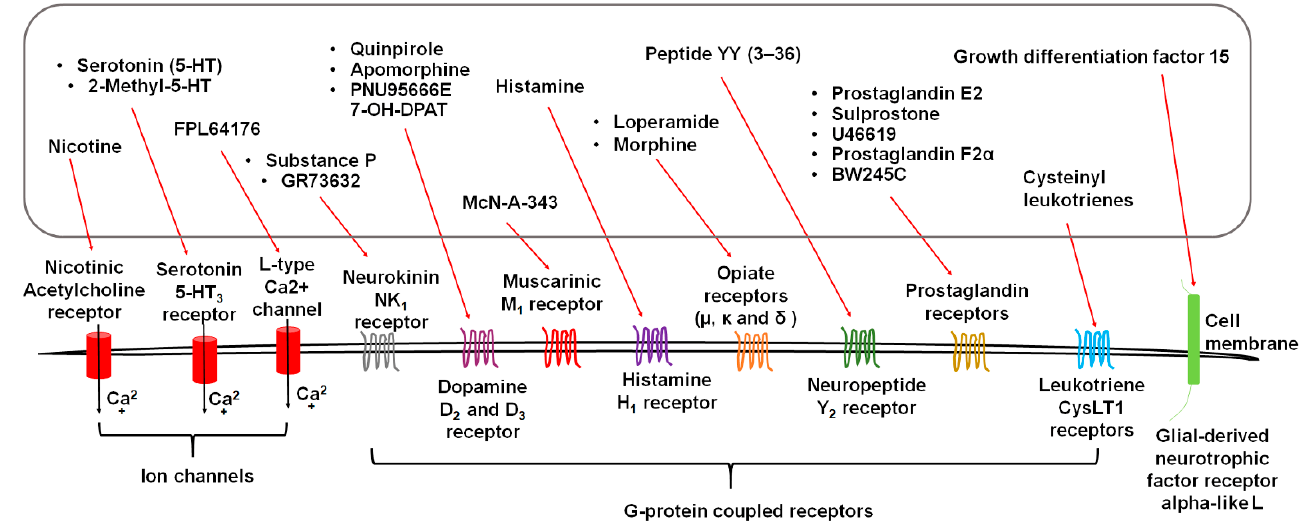
Figure 2. A schematic representation of emetic ligands or agonists, acting on the corresponding cell membrane-located receptors, including calcium-permeable ion channels and G-protein coupled receptors.